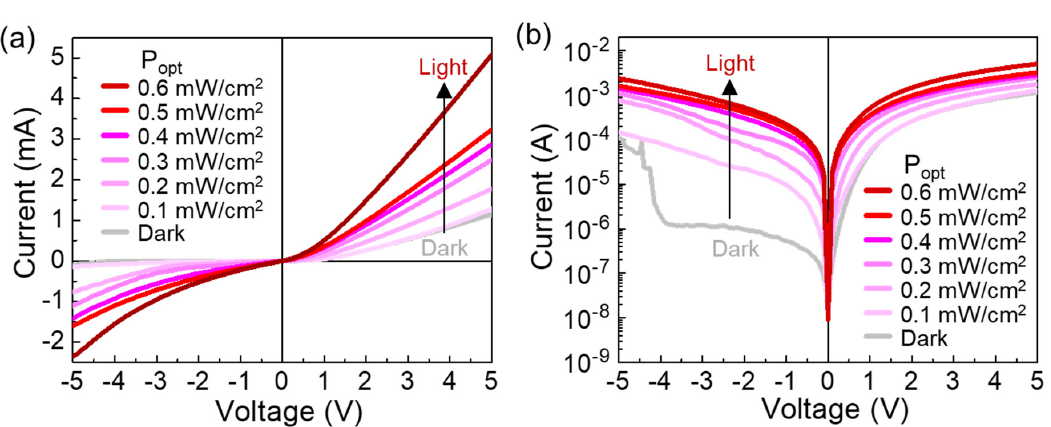
Figure 5. I–V characteristics of the Y3 device under UV illumination with various P opt : ( a ) linear scale and ( b ) semi-logarithmic scale.